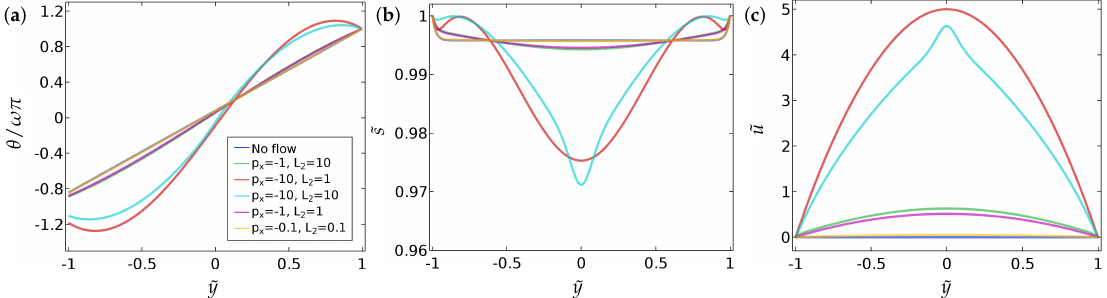
Figure 3. The effect of the fluid flow on ( a ) the director orientation ( θ ) , ( b ) the order parameter ( ˜ s ) , and ( c ) the velocity ˜ u , at equilibrium ( ˜ t = 10 ) , for the case of asymmetric boundary condition (Equation (16)). The values of the parameters used are B = 1/3, ω = 1/2, L ∗ = 10 − 3 and L 1 = 10 − 6